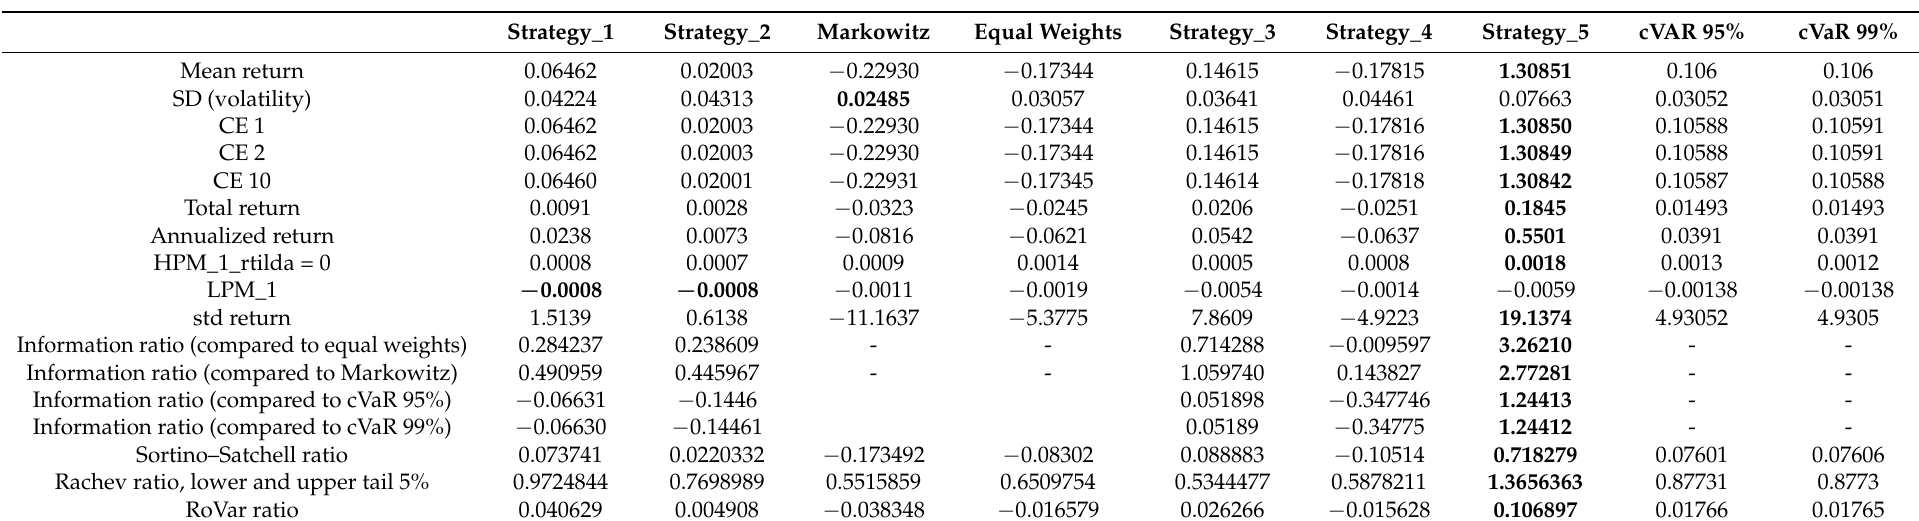
Table 1. Portfolio performance of simulated